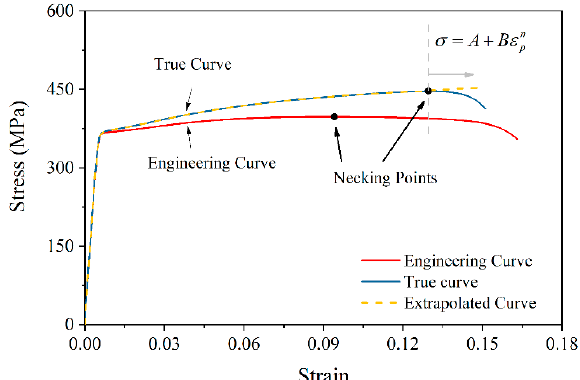
Figure 2. Stress-strain curves for experimental data processing. The red solid curve is the engineering stress-strain curves. The blue solid curve is transformed through the red one by plastic incompressibility condition. To compensate for the non-uniform deformation beyond necking, the blue solid curve is extrapolated by the power law of Ludwik. Yellow dash curve represents modified curve which could be used in calibrating constitutive model.